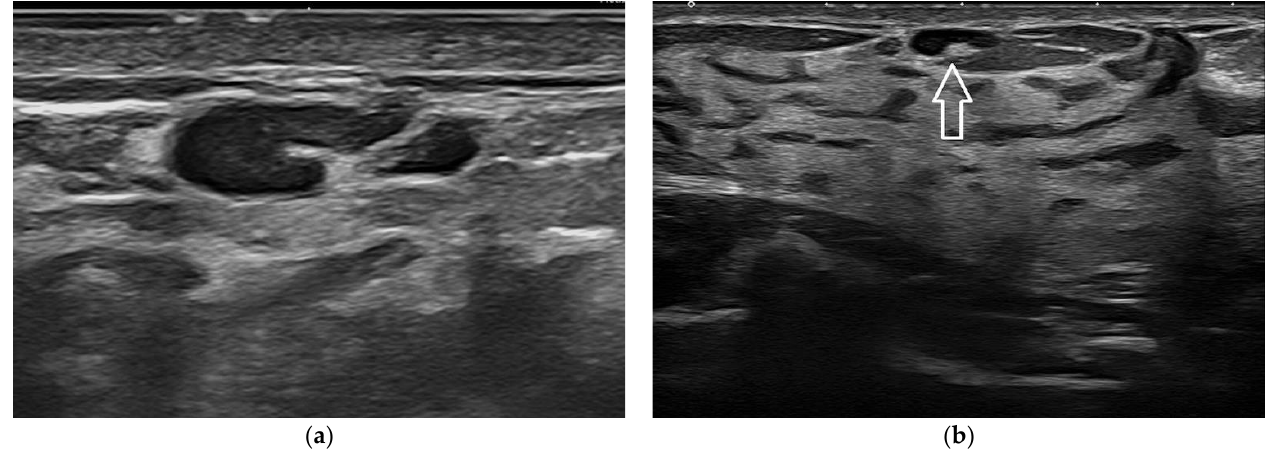
Figure 7. Normal intramammary lymph node. Being very superficial, this lymph node is better depicted in its cortex and hilum anatomy when imaged at 22 MHz ( a ) than at 15 MHz ( b ).